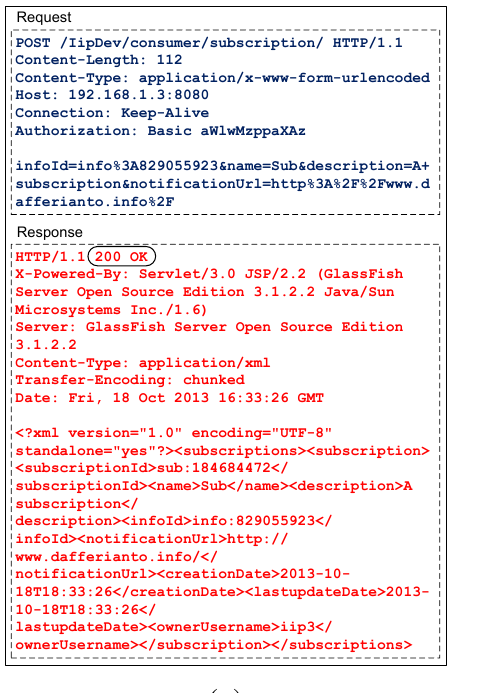
Figure 15. Wireshark captures of: ( a ) An information consumer successfully subscribes to an information channel; ( b ) An information consumer is rejected when trying to subscribe to an information